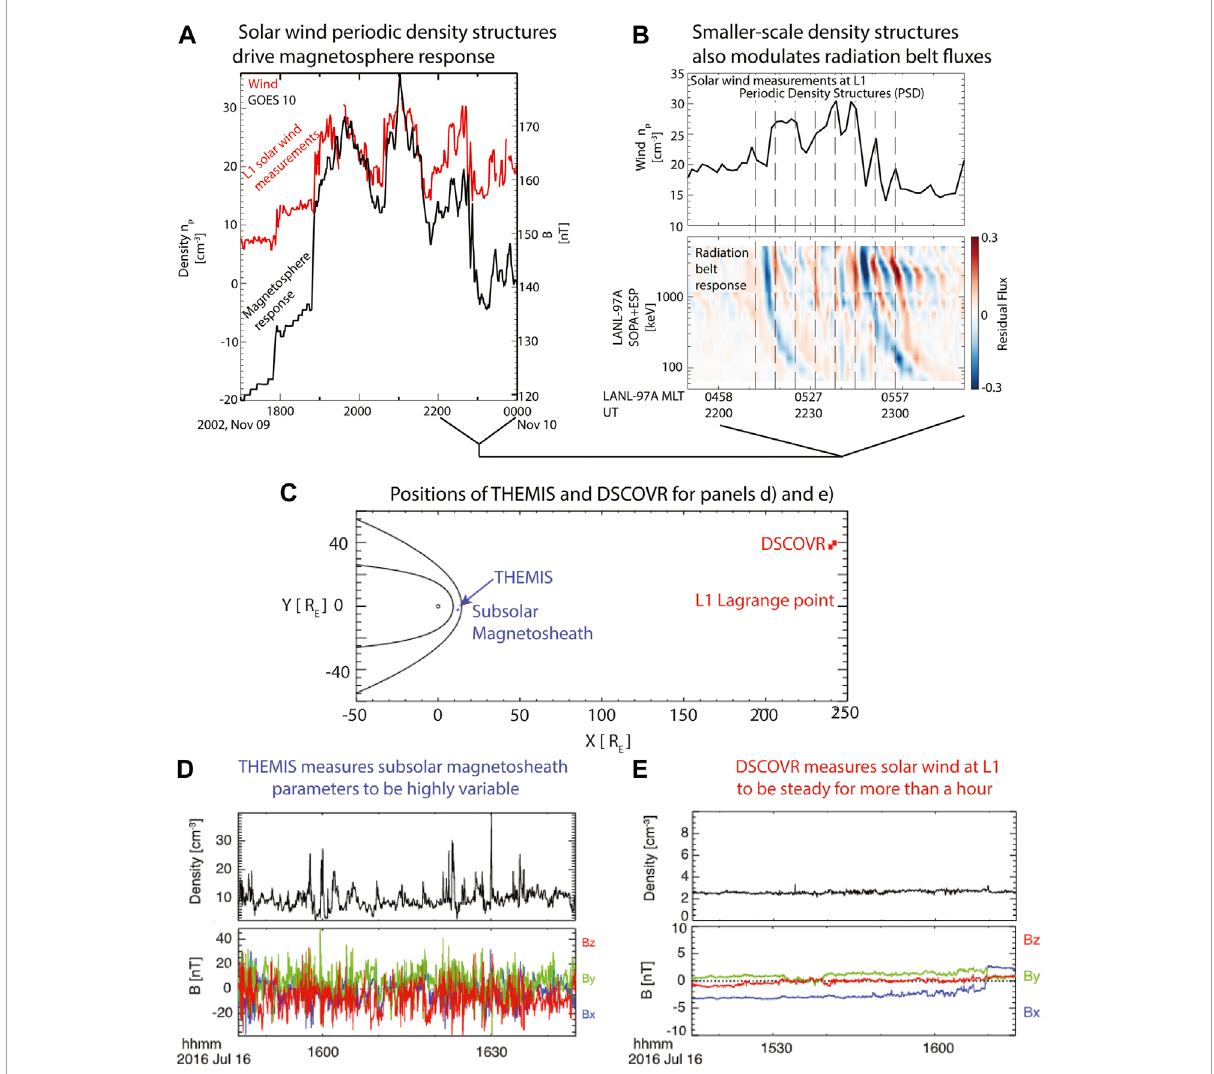
FIGURE 1 Solar wind periodic density structures (PSD) affects magnetosphere response. (A) comparison of solar wind proton density (red) and north-south magnetic field component at GOES 10; (B) detail of solar wind density measured by Wind at L1, and electron residual flux in the radiation belts by LANL-97A. Adapted from Di Matteo et al. (2022). Steady solar wind measurements at L1 does not guarantee steady local parameters in the subsolar magnetosheath. (C) Location of DSCOVR and THEMIS spacecraft, (D) THEMIS measures substantial variation in local plasma parameters, (E) DSCOVR measures very steady solar wind parameters at L1 during the corresponding period. Adapted from Walsh et al.